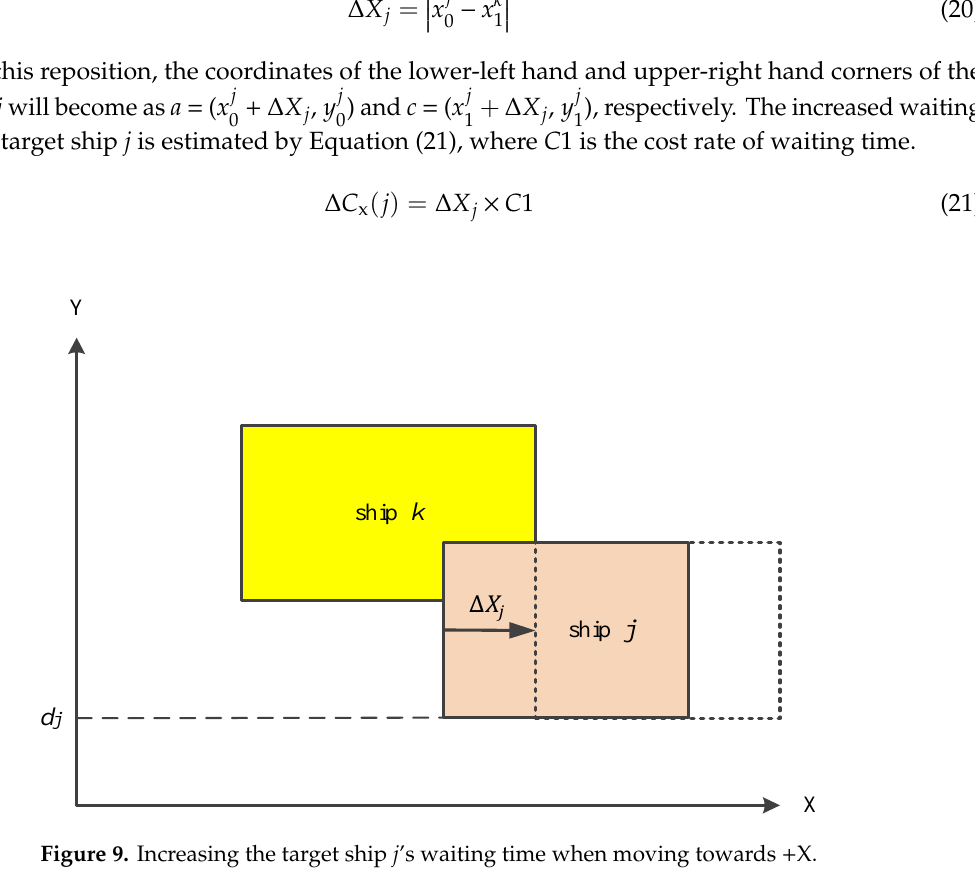
Figure 9. Increasing the target ship j ’s waiting time when moving towards +X.